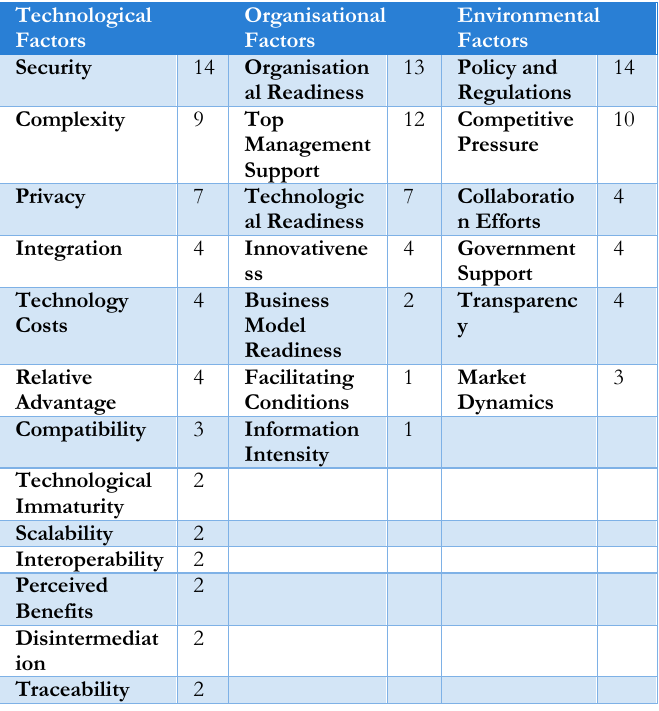
Table 2. Summary of Blockchain Adoption Factors